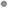
Effect of gap (A-D) and overlap (E-F) training on group data.Intersubject mean±95%CI saccade median latency (A,B,E,F) and intersubject mean±95% CI %ES (C,D,G,H) for ESM (●) and Norm (●) groups is shown. To improve clarity, error bars are only plotted in one direction where they would extensively overlap.